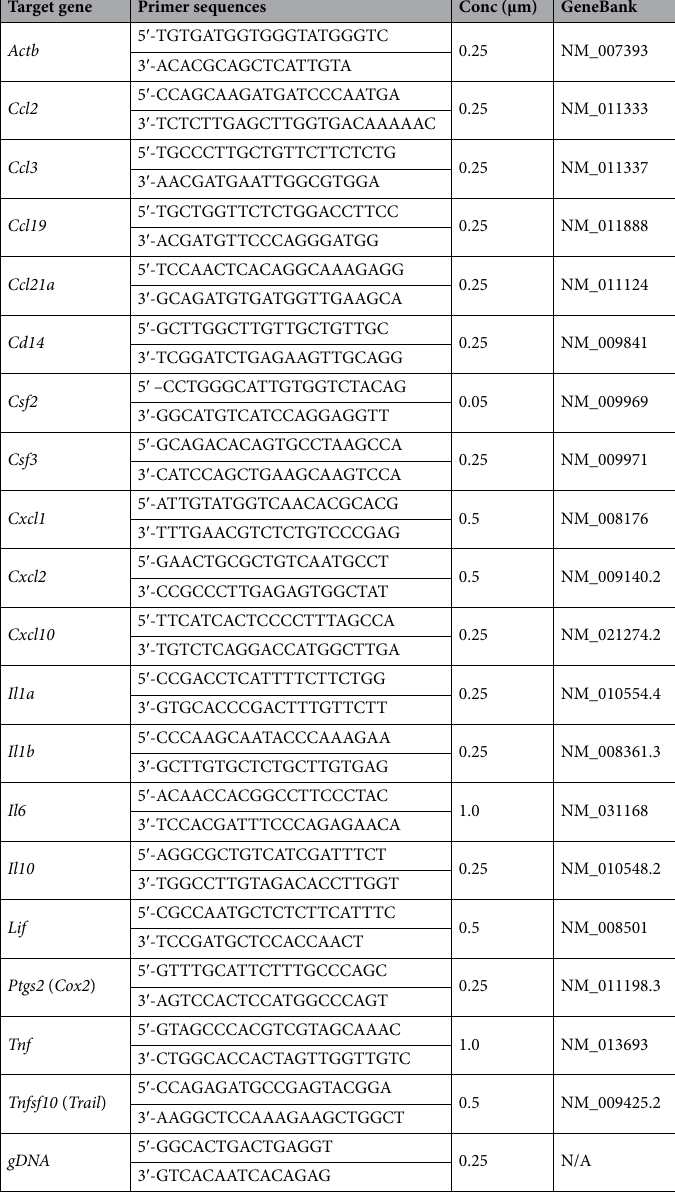
Table 1. Primers and target mRNA for qPCR analysis. 5 ′ represents forward primer sequence and 3 ′ represents reverse primer sequence. Sequences are from 5 ′ to 3 ′